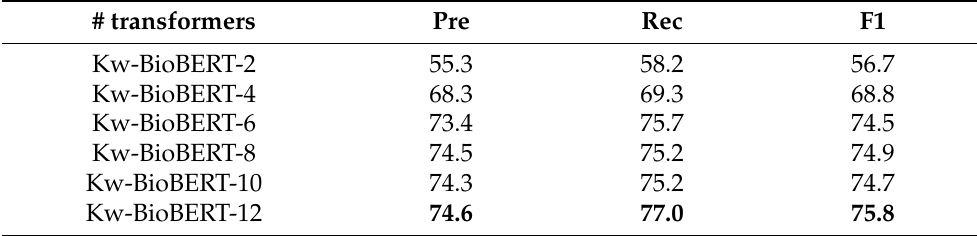
Table 3. Number of transformer layers vs. performance. The highest value of each metric is marked in bold.